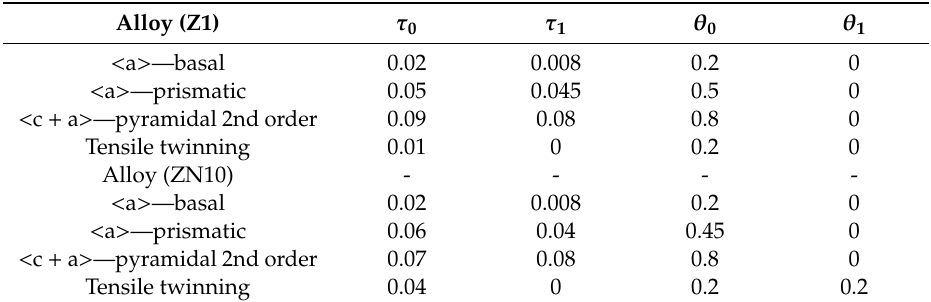
Table 2. Simulation parameters for deformation modes and twinning used in the simulation (unit of all shear stress values is GPa).